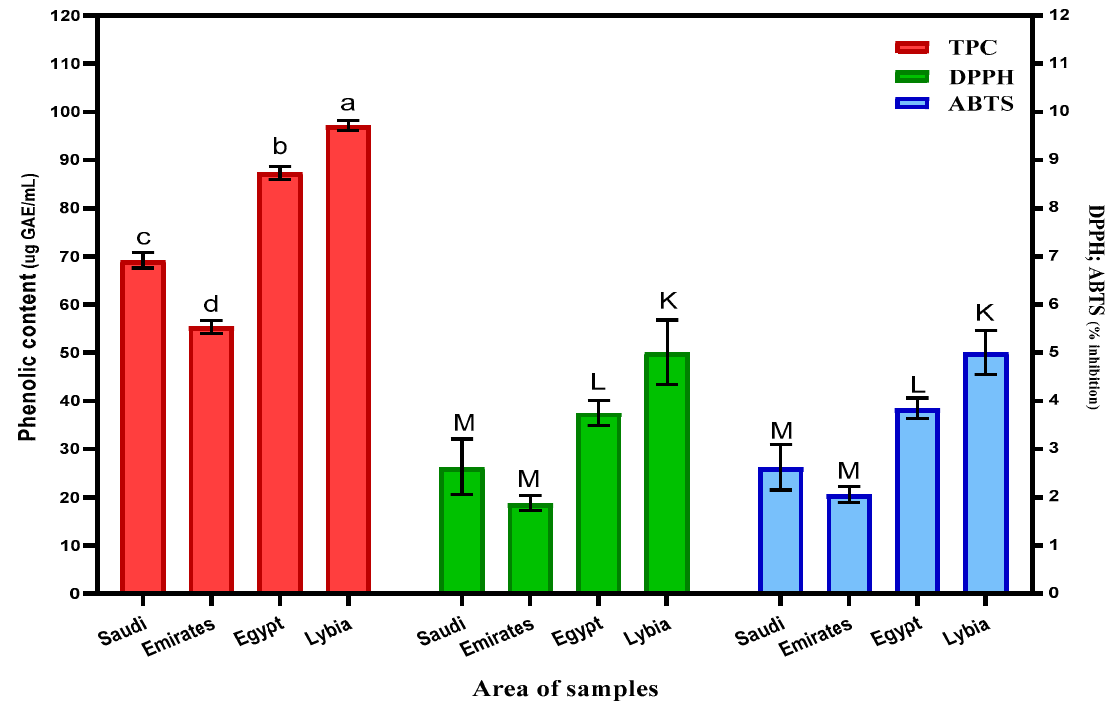
Figure 1. Total phenolic content and antioxidant activity for the collected camel milk from the Arabian Peninsula and North African regions. The columns with the same superscript le tt ers show non-signi fi cant di ff erences ( p = 0.05). TPC: total phenolic compound contents determined as microgram Gallic acid equivalents per milliliter of milk sample. DPPH: DPPH (2, 2-diphenyl-1- picryl-hydrazyl-hydrate free radical solution), ABTS+: ABTS+ scavenging (2, 2 ′ -Azinobis [3- ethylbenzothiazoline-6-sulfonic acid]-diammonium salt).